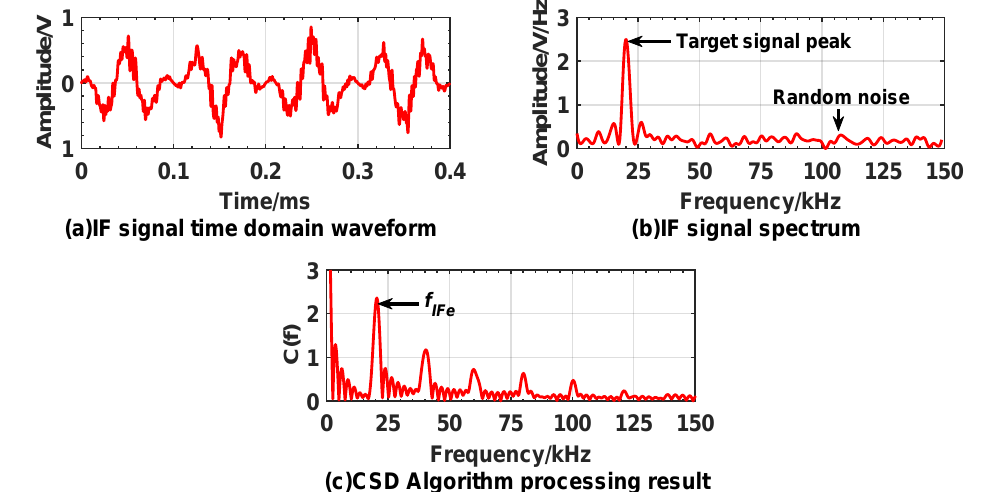
Figure 10. Experiment result when expected distance is 3 m with no smoke interference. ( a ) is time domain waveform of IF signal; ( b ) is spectrum of IF signal; ( c ) is processing result of the CSD algorithm.